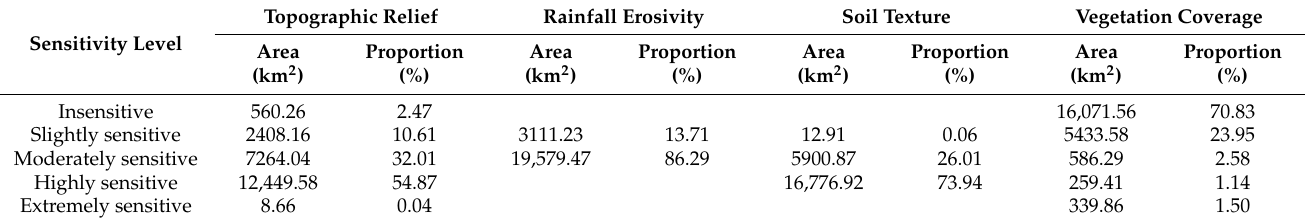
Table 7. Comprehensive ecological sensitivity analysis results.